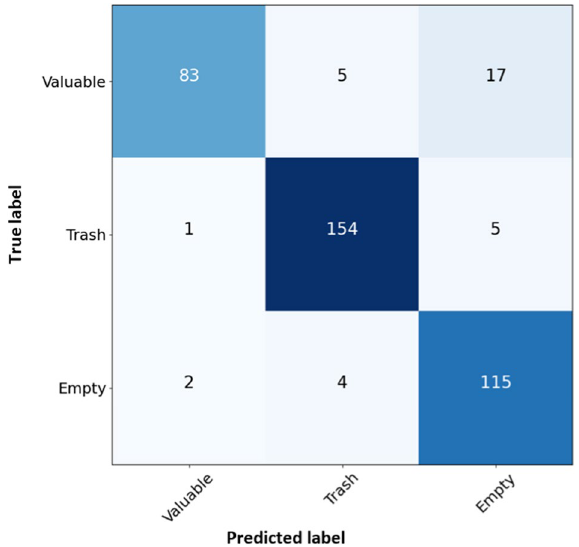
Fig. 25 Confusion matrix with respect to the three fundamental